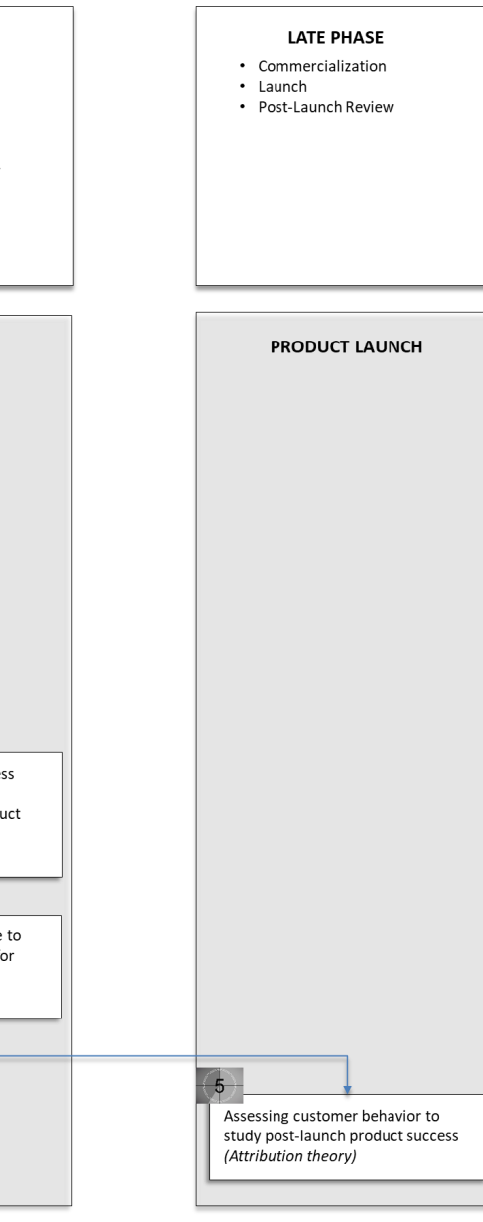
Figure 3. NPD case study flowchart.